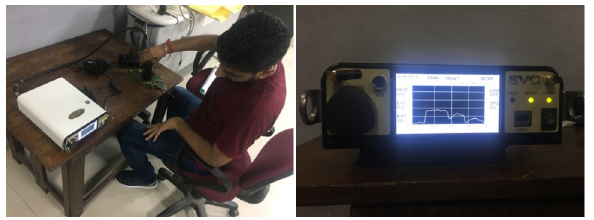
Figure 5.Laser guided spectral reflectance measurement for mango leaves and recorded spectral signature over LCD